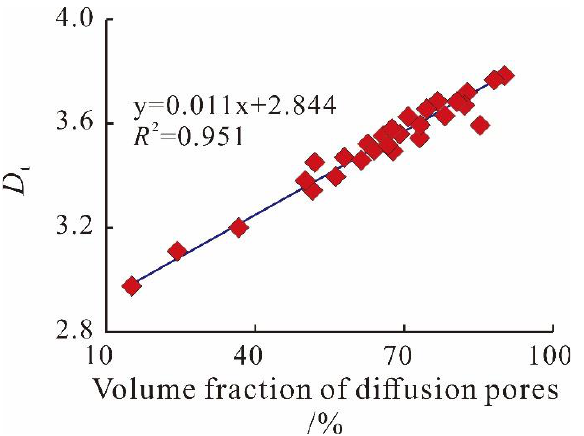
Figure 8. Relationship between volume fraction of diffusion pores and comprehensive fractal di-